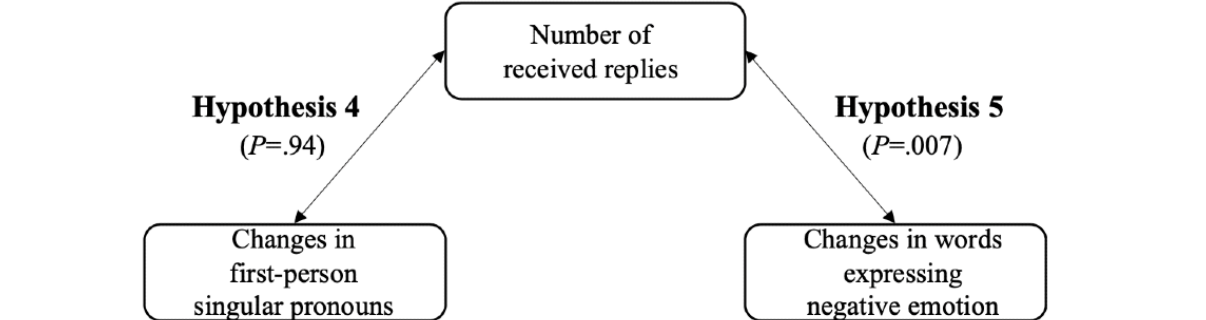
Figure 5. Theoretical framework and results for Hypothesis 4 and Hypothesis